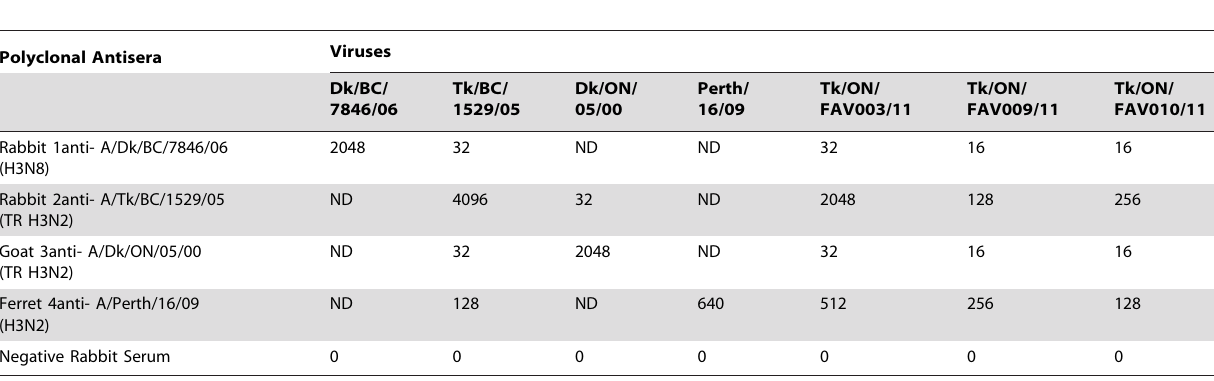
Table 4. Antigenic characterization of triple reassortant H3N2 viruses isolated from turkeys by hemagglutination-inhibition assay using turkey red blood cells and various reference H3 antisera.